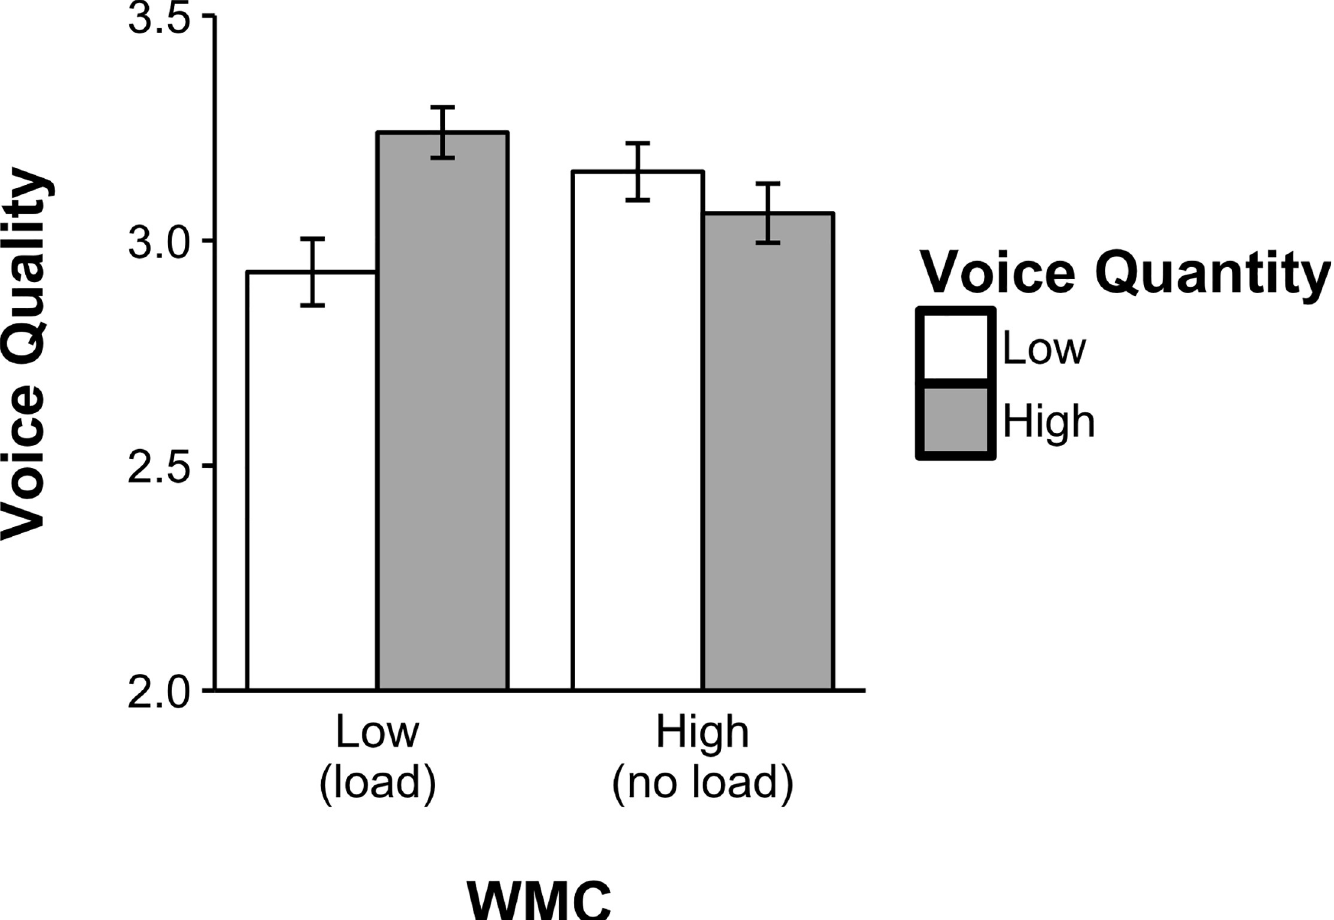
Fig 2. Interaction WMC � voice quantity on voice quality study